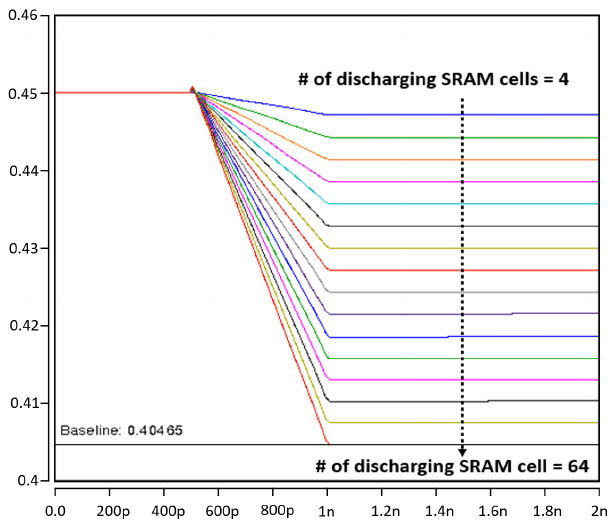
Figure 10. Comparison of read bitline (RBL) discharging range with different number of SRAM bitcells (4 cells–64 cells).